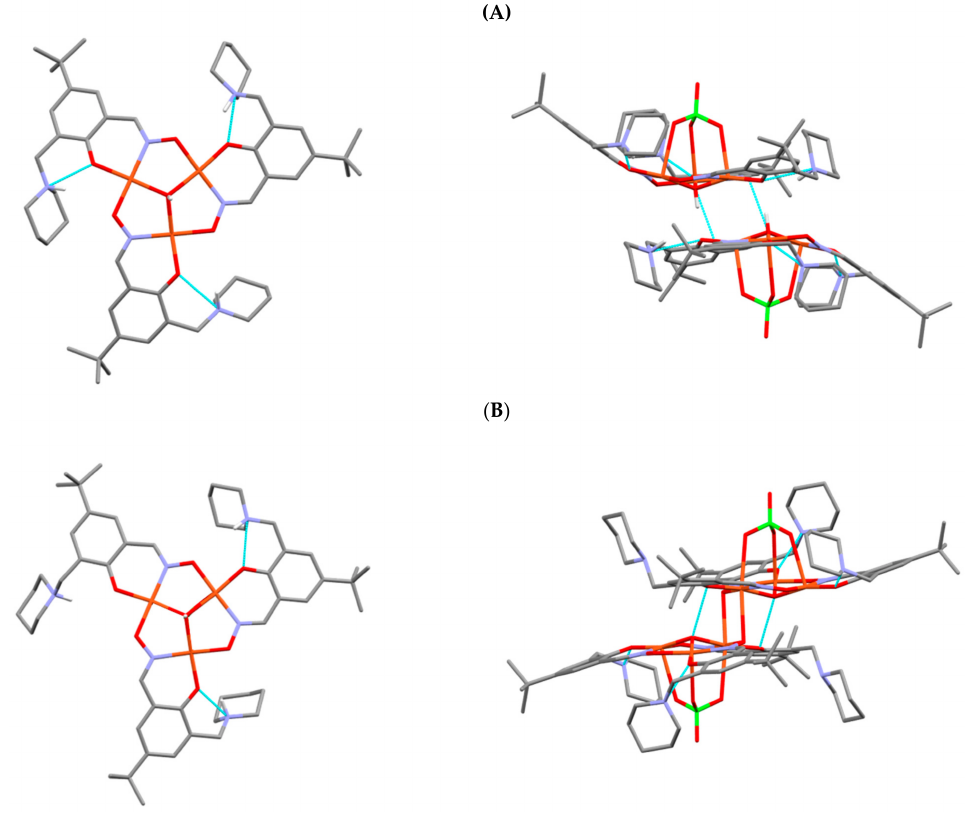
Figure 13. Components of the two crystalline forms ( A , B ) of the hexanuclear complexes { [Cu 3 OH( L 9 H) 3 (ClO 4 )](ClO 4 ) } 2 .2H 2 O.2MeCN and { [Cu 3 OH( L 9 H) 3 (ClO 4 )](ClO 4 ) } 2 .11H 2 O.MeCN. The trinuclear entities [Cu 3 OH( L 9 H) 3 ] 2+ and the hexanuclear units [Cu 3 OH( L 9 H) 3 (ClO 4 )] 22+ are shown on the left and right, respectively. H-atoms not involved in H-bonding have been removed for